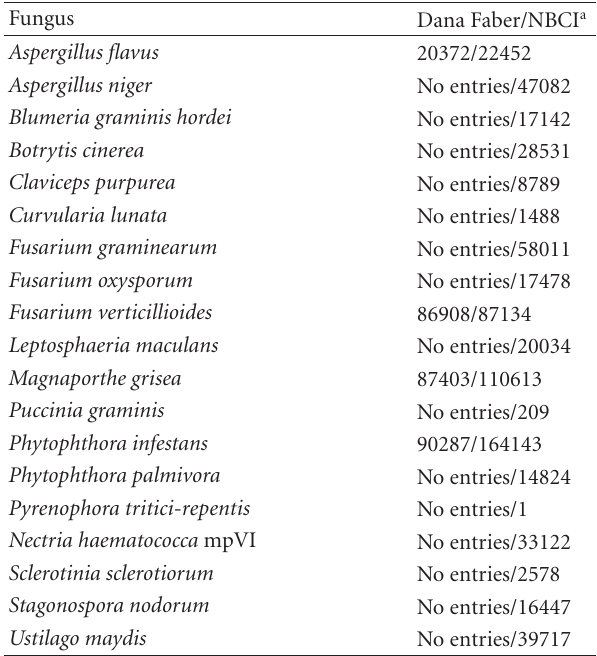
Table 4: Number of ESTs entries for some fungi of interest up